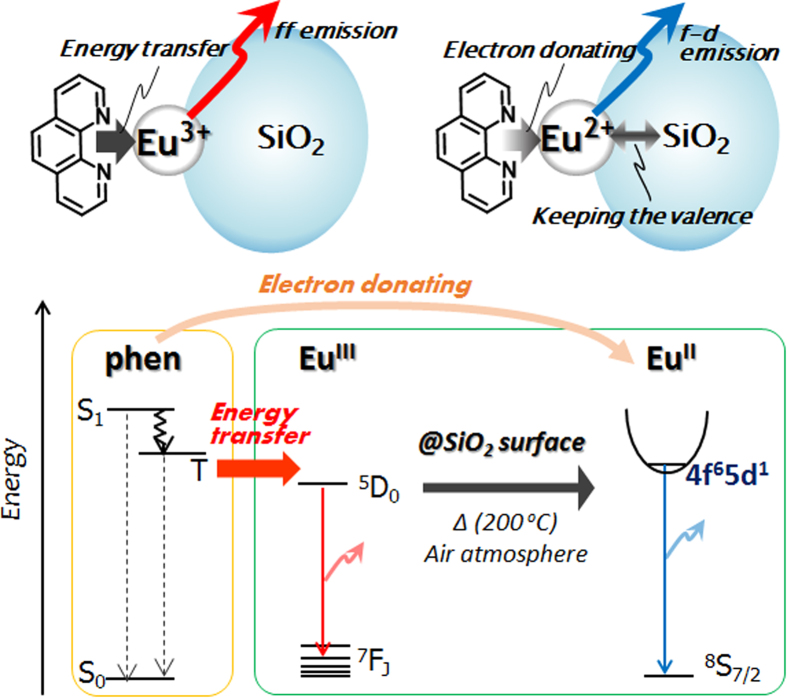
Energy diagram for as-prepared and sintered SiO2/Eu/phen nanoparticles.